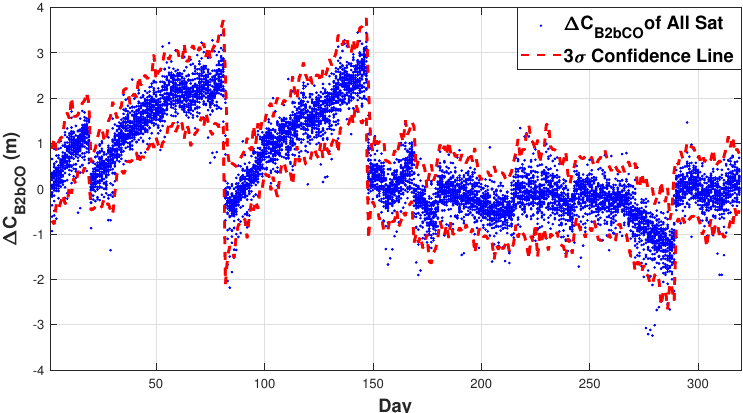
Figure 2. The bias of B2bCO changes in the long